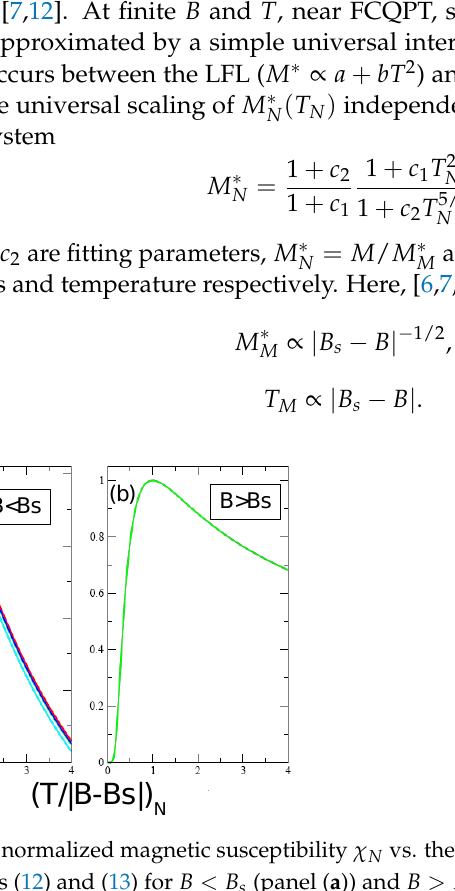
Figure 11. The magnetic field dependence of peak temperature T M ( χ ) . Panel ( a ) shows the B dependence of CuPzN, extracted from data [25]. Panel ( b ) demonstrate the B YbAlO 3 , extracted from experimental data [24]. The calculated straight lines T M = a Equation (17). The excellent coincidence is seen, showing that Equation (17) holds for both CuPzN and YbAlO 3